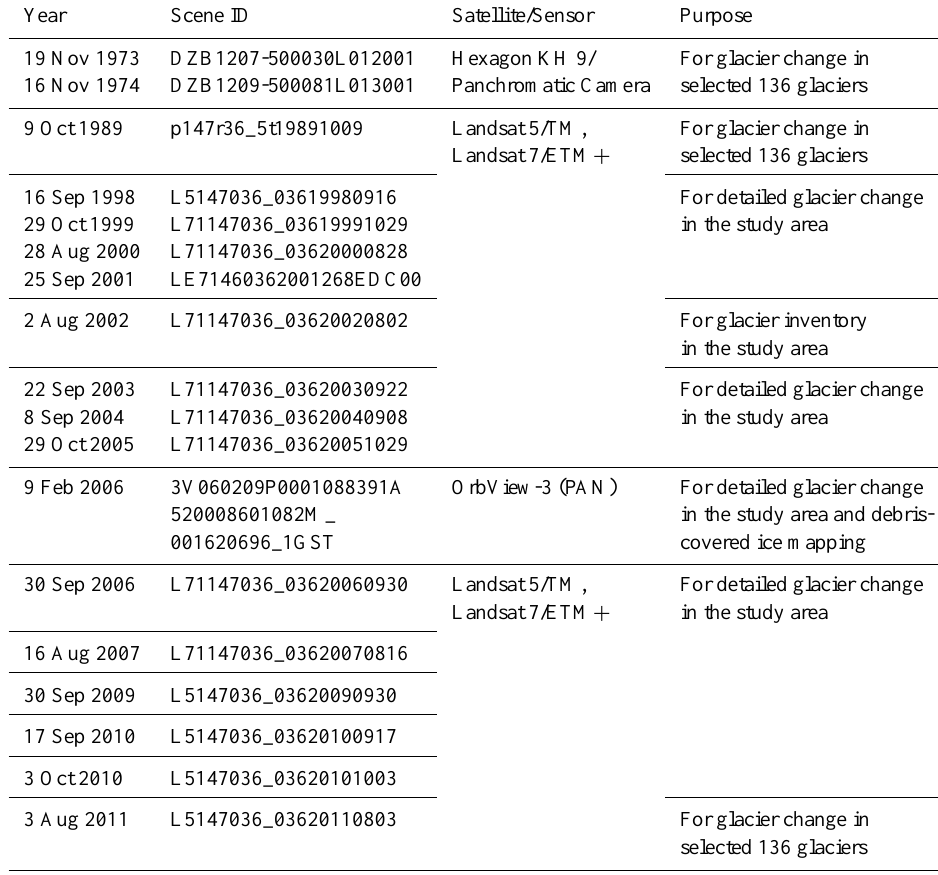
Table 1. Details of the USGS satellite data used in the present study.